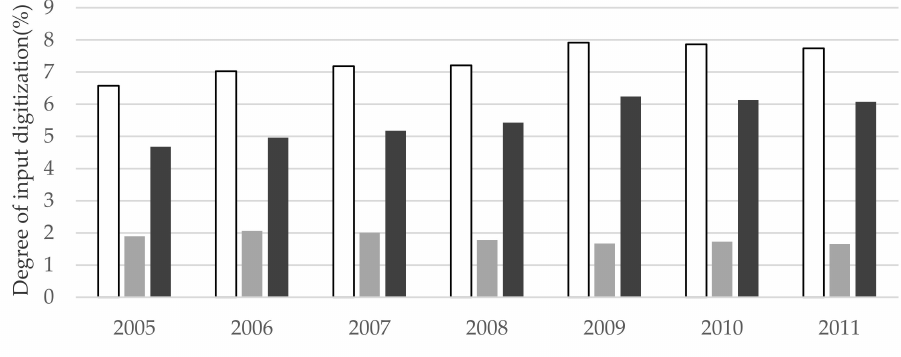
Figure 3. Distribution of different sources of input digitization in developing